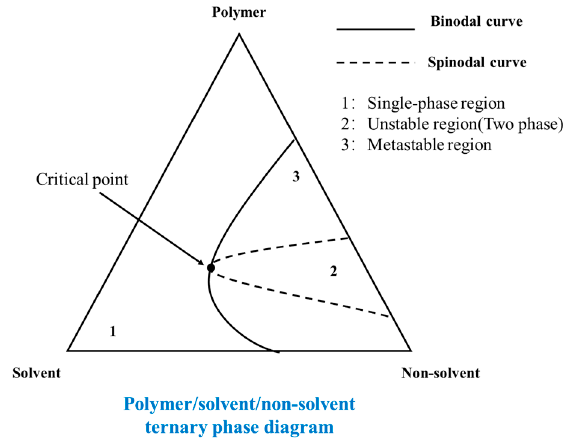
Figure 16. Phase diagram for NIPS method.